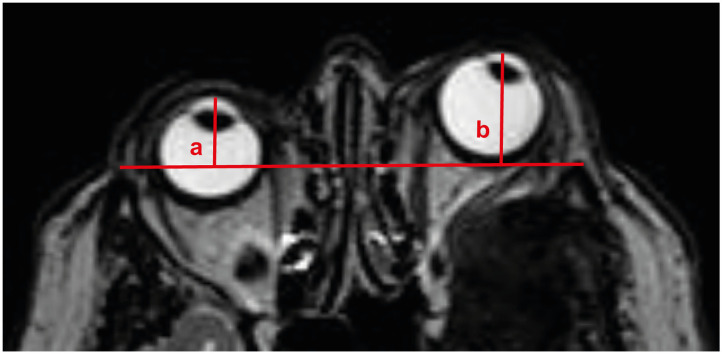
llustration of preoperative calculation of exophthalmos indices. The distance of the anterior limit of each eye globe to a line between both anterior margins of the frontal processes of the zygomas is measured. EI is calculated as the distance ratio between the pathological eye and the normal eye (b/a = 22.8 mm/15.3 mm = 1.5 for the presented case). EI, exophthalmos index.